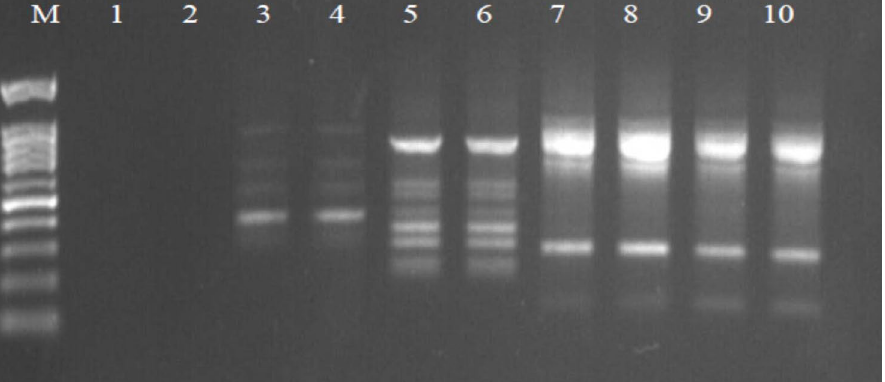
Fig. 2. Agarose gel electrophoresis of OPW-2 amplified product. The electrophoresis pattern of genomic DNA extracted from fenugreek ( Trigonella foenum-graecum ) leaf samples: 1, control; 2, Th-1; 3, Th-2; 4, AVG; 5, MeJA; 6, Th-1 + AVG; 7 Th-1 + MeJA; 8, Th-2 + AVG; 9, Th-2 + MeJA; 10, MeJA + AVG; M, DNA size marker. Electrophoresis conditions: 1.5% agarose concentration, 75 V, 20 mA for 120 min, stained with ethidium bromide.